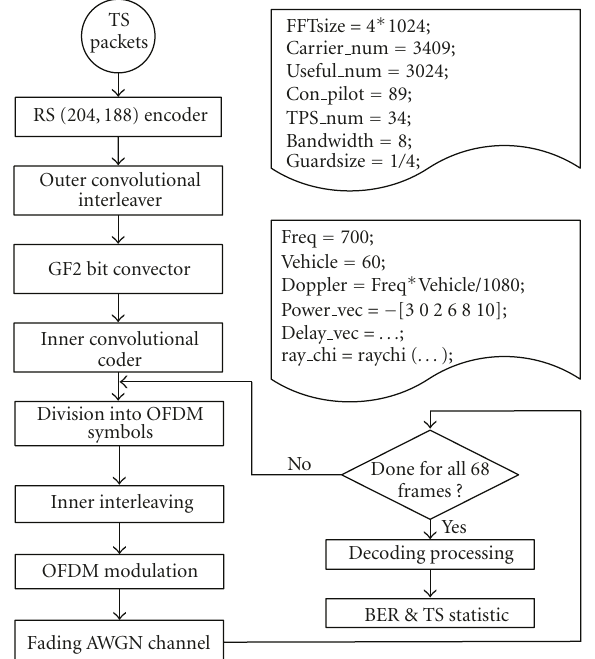
Figure 11: The “WBC over DVB-H” physical layer testbed.